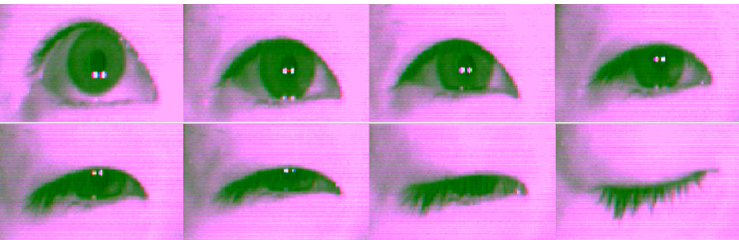
Figure 2. Schematic diagram of eyelid closure